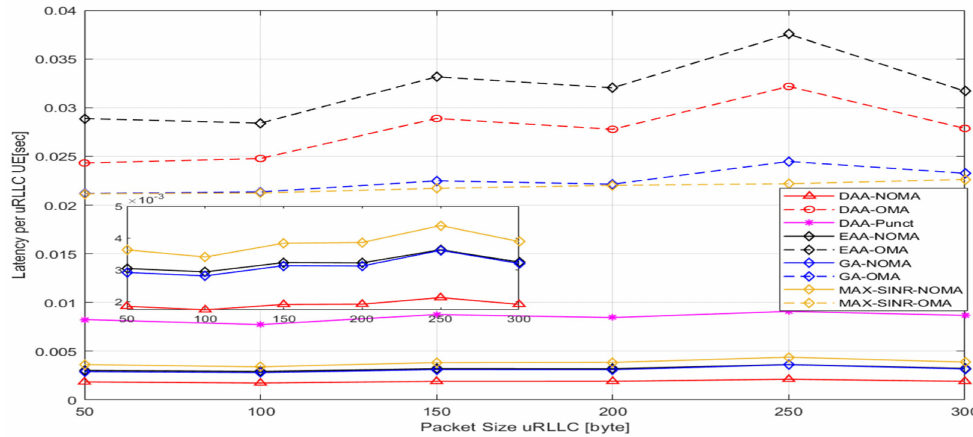
Figure 10. The DL average throughput for eMBB UEs versus offered load